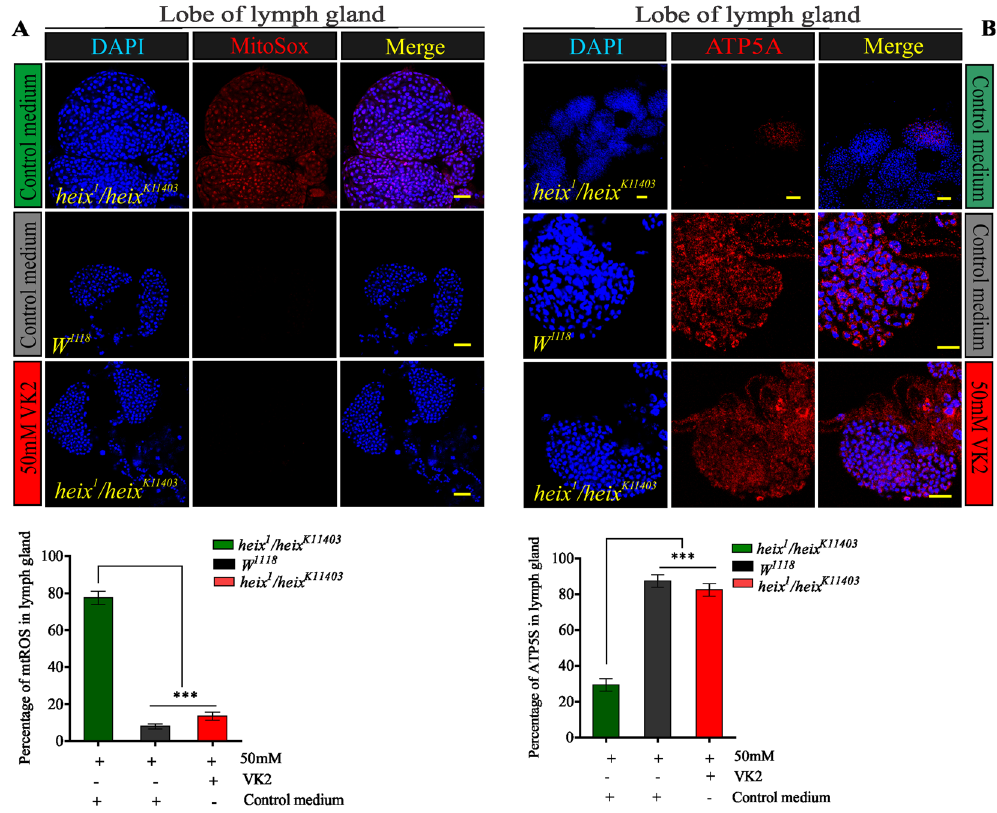
and mitochondrial ROS staining (Mito-SOX) (red). ( B ) Confocal microscopy showed inhibition in ATP production in Lymph gland of heix mutants, significantly increased by VK2 treatment. DAPI stain (blue) and anti-ATP antibodies (ATP5A). Control media contain 50 mM Ethanol (EtOH) and treatment media contain 50 mM VK2. Means normalized to control ( Canton S ). Error bars indicate SEM. Analysis of variance (AVOVA/ Dunnett: * P < 0.05, ** P < 0.01, *** P <